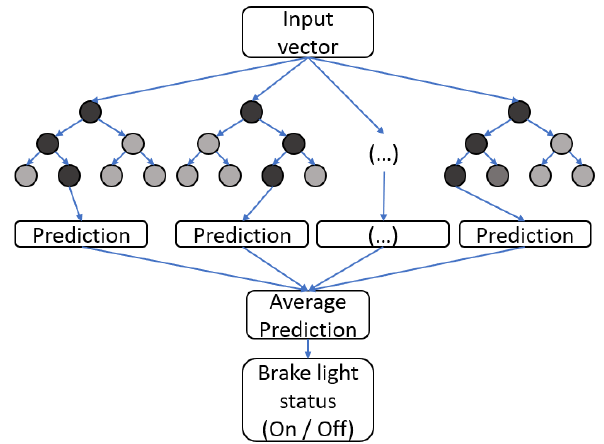
Figure 5. Workflow for the random forest